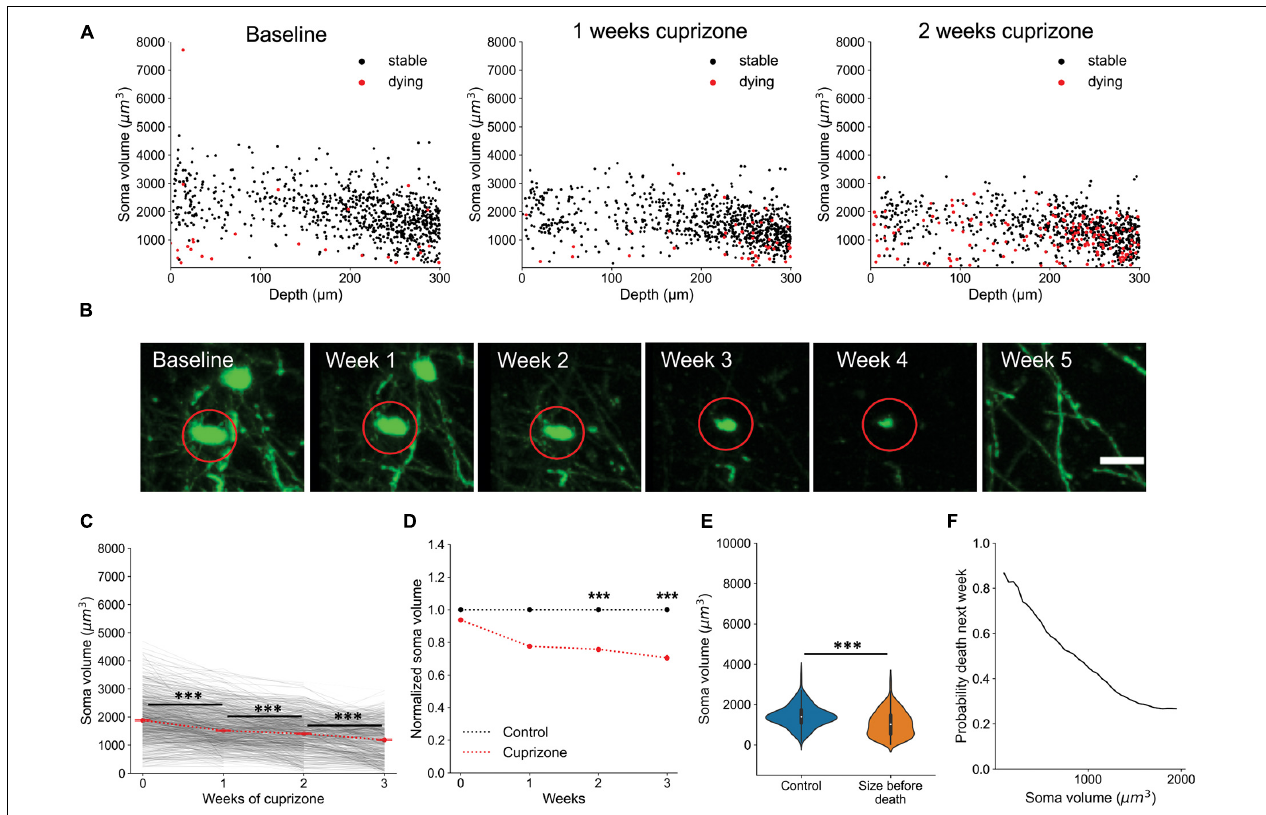
FIGURE 8 | Oligodendrocyte death can be predicted from cell soma volume. (A) Volume of cell somata within 1 week of dying (red) at baseline, 1 week cuprizone, and 2 week cuprizone timepoints. (B) Representative example of cell soma shrinkage throughout cuprizone treatment, resulting in eventual death. Scale bar: 20 µ m. (C) Plot of soma volume decrease for 860 cells during cuprizone treatment. (D) Plot of average soma volume of dying cells at each timepoint of cuprizone treatment relative to timepoint matched cells from control mice. All values are normalized to the mean soma volume of stable control cells at each matched timepoint. (E) Overall distribution of soma volumes for non-treated cells and cells within 1 week of death during cuprizone treatment. (F) Probability that a cell soma below a certain volume is within 1 week of death. Cells pooled from n = 4 cuprizone treated and n = 3 control mice. See Supplementary Table 1 for statistical tests and significance level for each comparison. *** p <